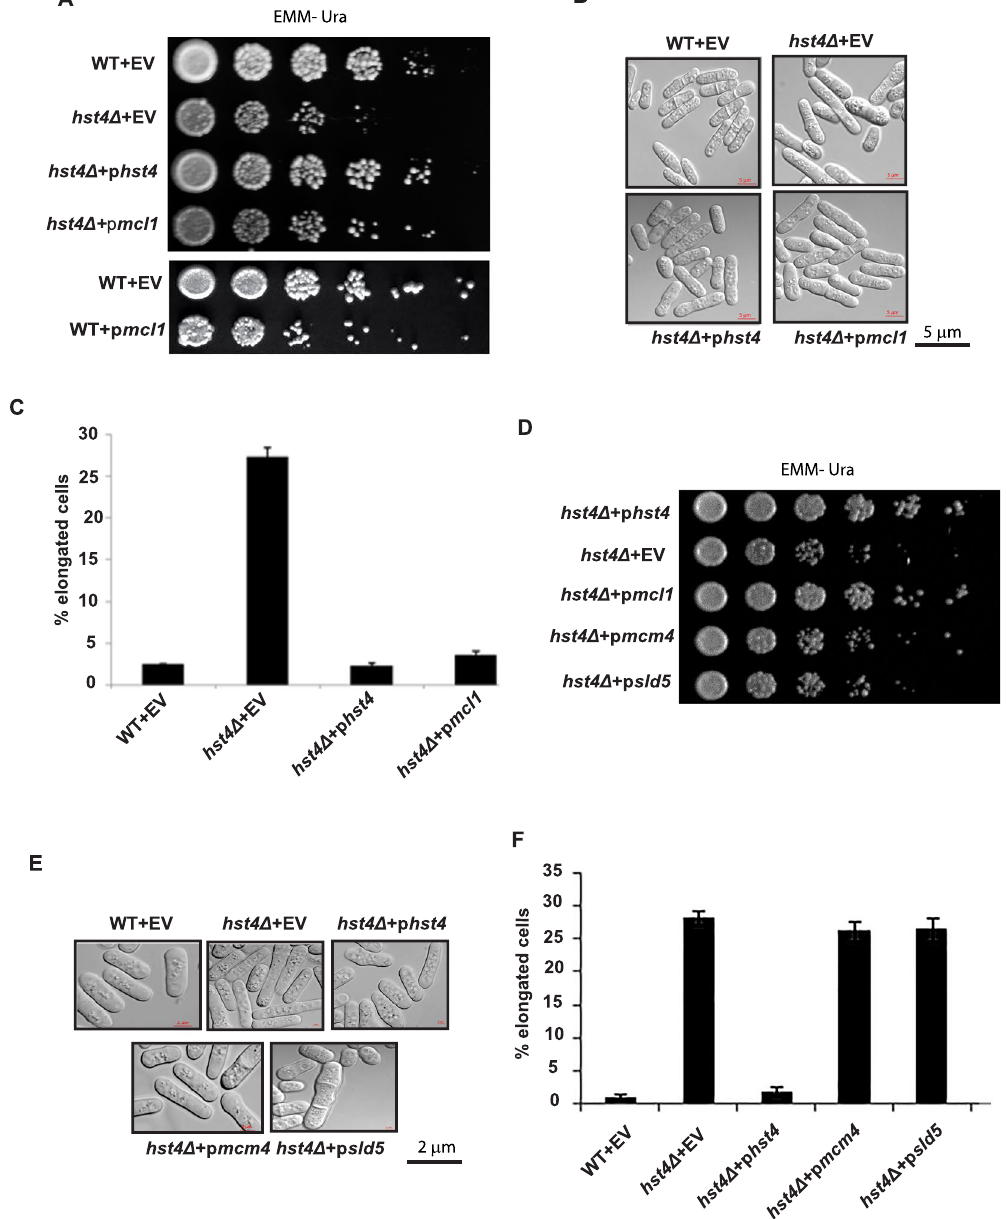
Figure 3. Mcl1 expression rescues the slow growth and elongated morphology phenotypes of hst4 Δ mutants. ( A ) Wild type strain (ROP191) or hst4 ∆ (ROP58) expressing hst4 , mcl1 or pRO314 (empty vector) were grown to OD 1, five-fold serially diluted, spotted onto EMM-Ura plates and incubated at 30 °C to assay growth rate. ( B ) Morphology of strains indicated in ( A ) were grown to saturation in liquid EMM medium at 30 °C and observed under phase-contrast microscope. ( C ) Plot showing quantification of elongated cells. Percentage elongated cells were determined by counting at least 100 cells from three independent experiments. Elongated cells were identified as cells that were greater than the size of a normal dividing cell ( > 14 µ m). Error bars represent standard deviation of the mean from three independent experiments. ( D ) hst4 ∆ mutant strain (ROP58) expressing mcm4 , sld5 or harboring pSLF272 (empty vector) were grown to OD 1, five-fold serially diluted, spotted onto EMM-Ura plates and incubated at 30 °C to assay growth rate. ( E ) hst4 Δ mutant cells expressing indicated genes were grown in EMM-URA medium at 30 °C and observed under microscope for examining morphology. ( F ) Plot showing quantification of elongated cells in indicated strains. Percentage elongated cells were determined by counting at least 100 cells from three independent experiments. Average and standard deviations were calculated from three independent